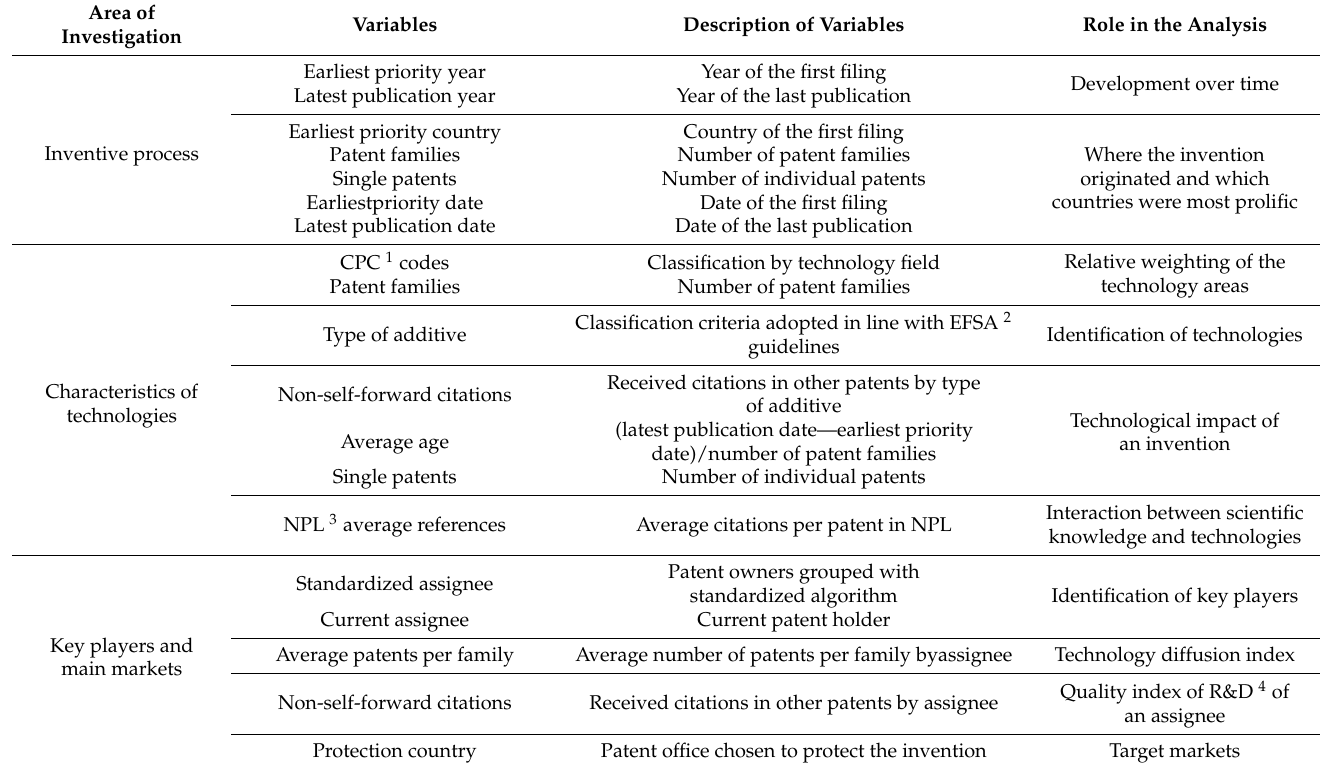
Table 1. Patent variables and their use in the